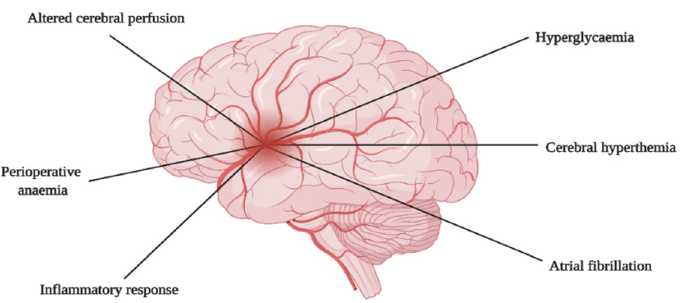
Figure 2. Mechanisms of brain injury.